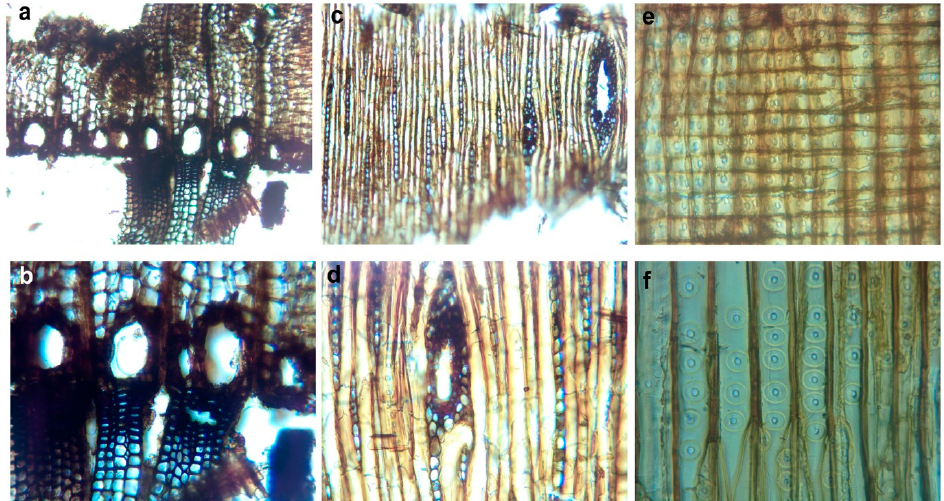
Figure 5. Microphotographs of wood sections under the microscope in transmitted light showing the anatomical characteristics of Cedrus libani A.Rich.: ( a , b ) transverse section (TS); ( c , d ) tangential longitudinal section (TLS); ( e , f ) radial longitudinal section (RLS).